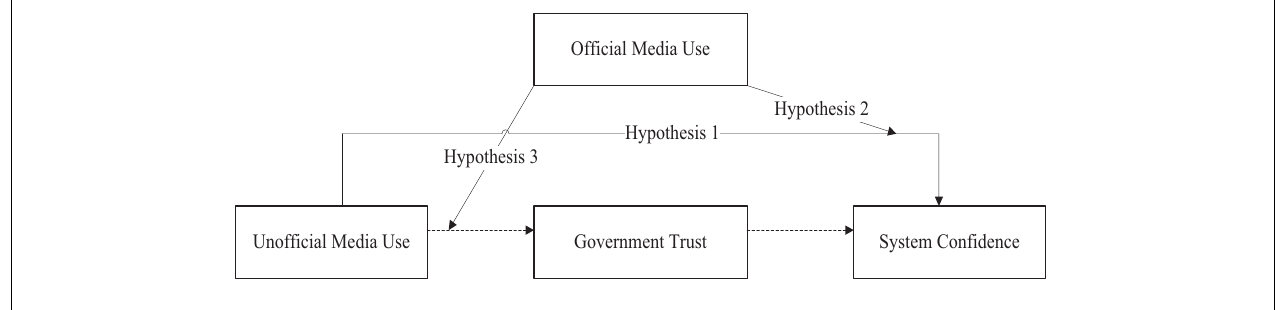
FIGURE 1 | Theoretical